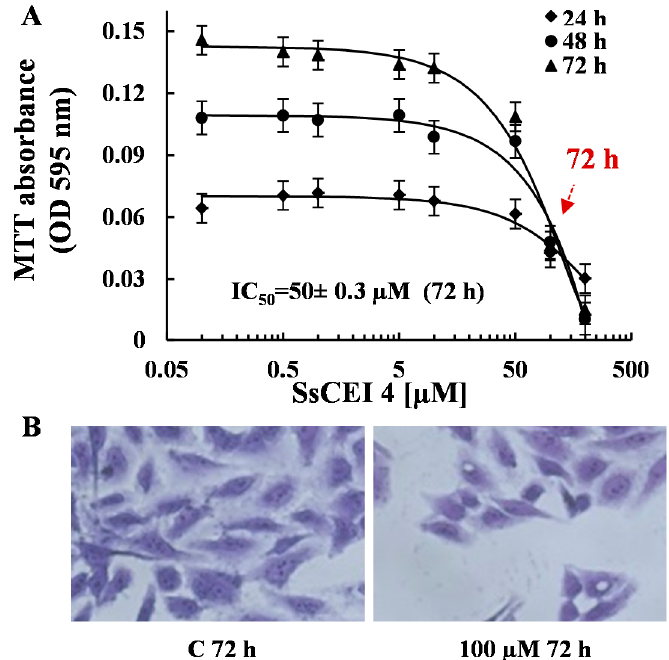
Figure 3. SsCEI 4 inhibits cell growth of U2OS cells in a dose- and time-dependent manner. U2OS cells were grown in the presence or absence of increasing concentrations of SsCEI 4 (0.1–200 µM) for 24, 48 or 72 h. ( A ) Inhibition of cell growth was assessed by 3-(4,5-dimethylthiazol-2-yl)-2,5-diphenyltetrazolium bromide (MTT) assay and values represent the means ± SD of triplicate data from three independent experiments; ( B ) microscope image (200×) of U2OS cells treated for 72 h with 100 µM SsCEI 4 and stained with crystal violet. Cells treated with DMSO were used as control (C).